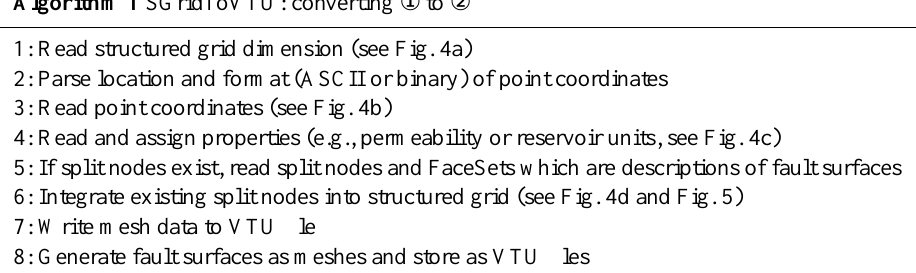
Algorithm 1 SGridToVTU: converting ‹